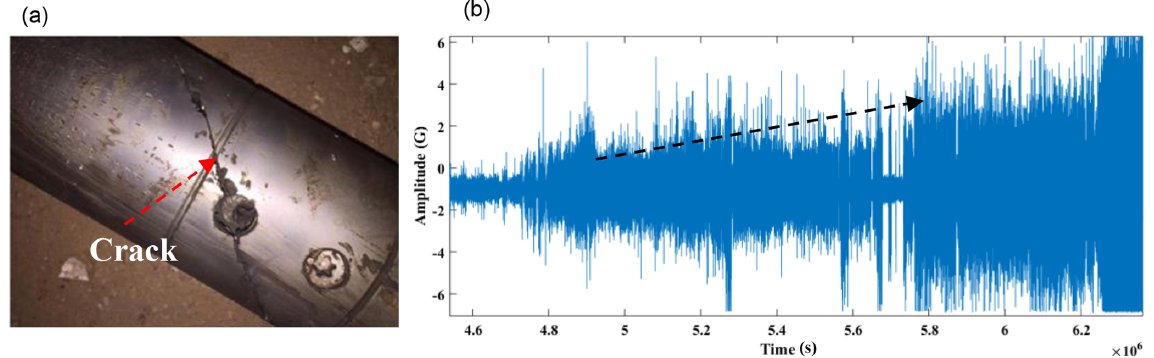
Figure 10. The actual photo of the drillstring damage (a) and the vibration signal measured in the early stage of the drillstring damage (b)